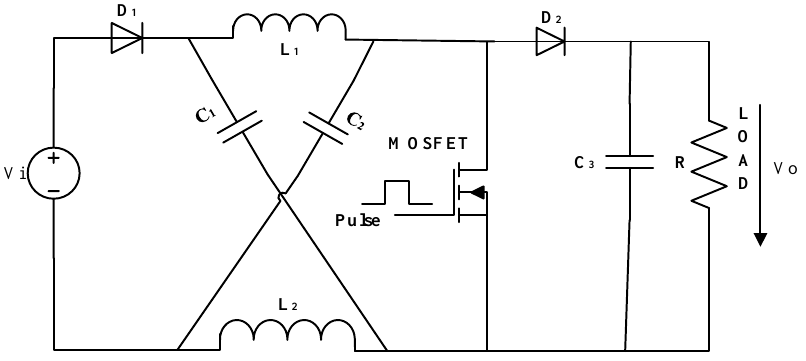
Figure 1. The traditional Z-source DC-DC converter (ZSC) [5].